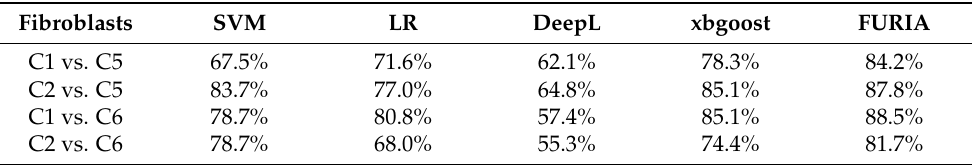
Table 2. Percentage of accuracy for the different algorithms considering MMPs/TIMP-3 expression by